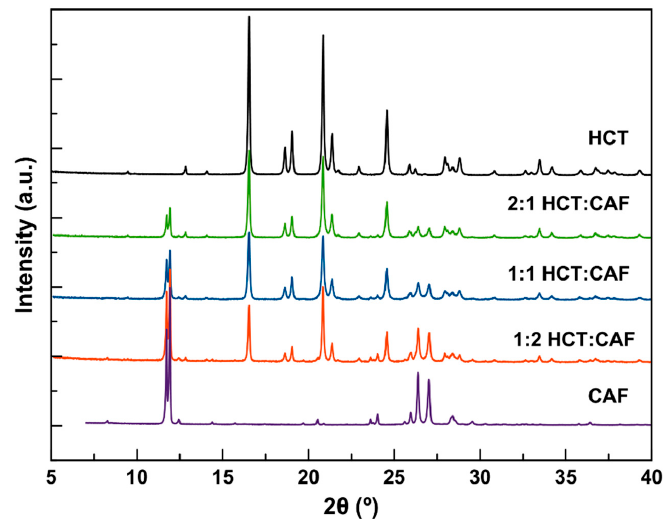
Figure 1. Powder X-ray diffraction (PXRD) patterns of the HCT and CAF physical mixtures obtained by neat grinding, and the corresponding reactants.